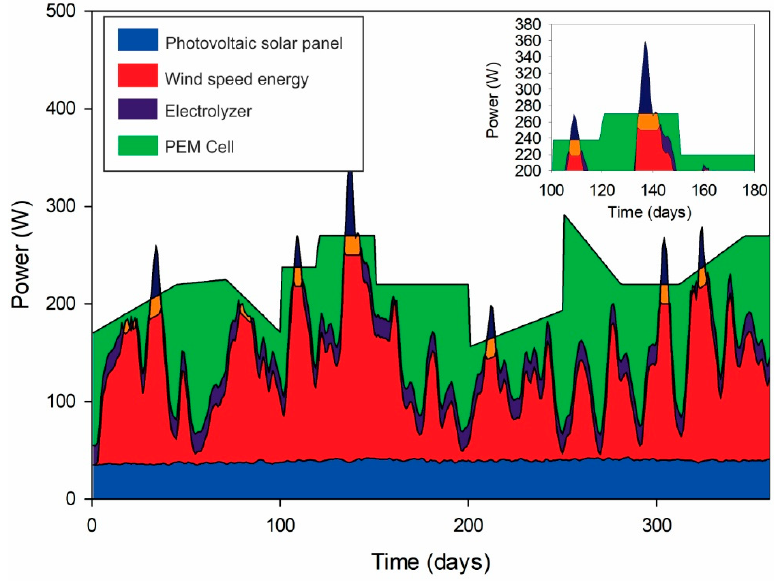
Figure A1. Power for Puerto Bolivar.